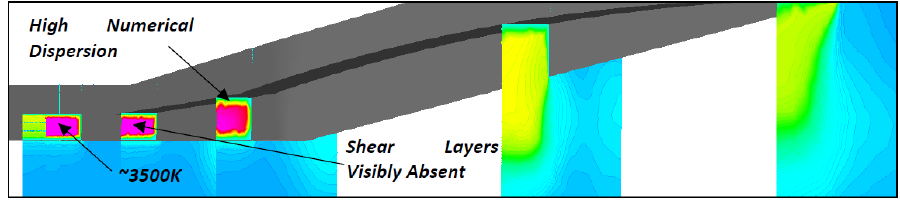
Figure 34. Integrated 3-D scramjet, temperature (K) contour planes.